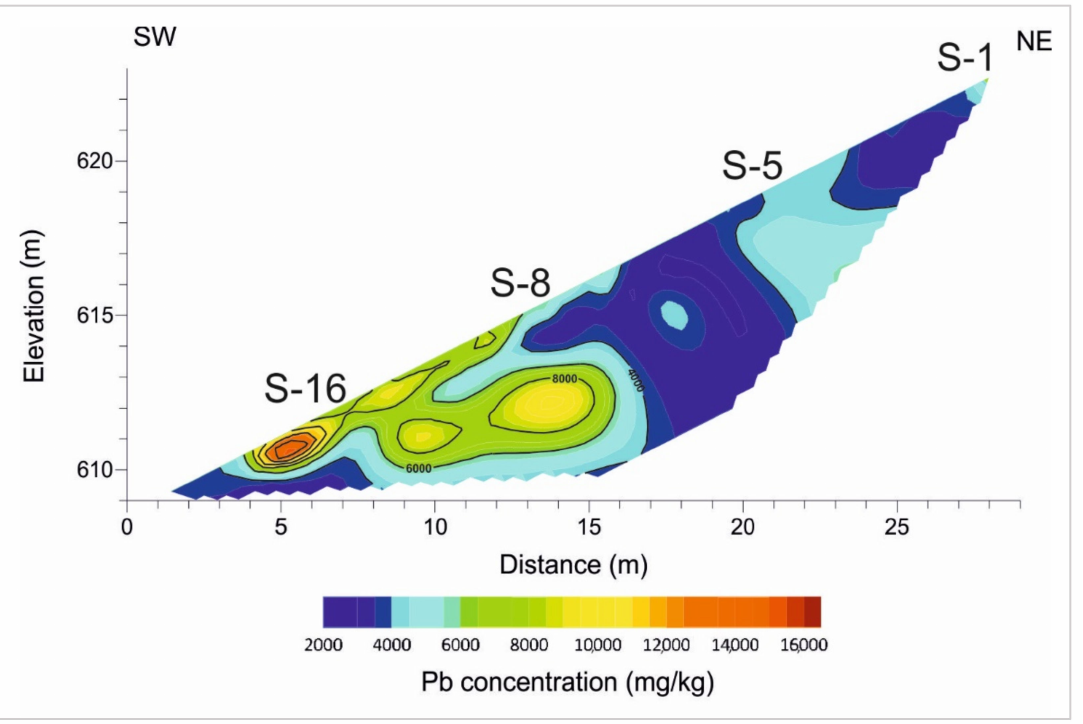
Figure 7. Image of the lead distribution in the profile studied along the slope of the tailing dam. The position of the samples with the highest metal concentration is